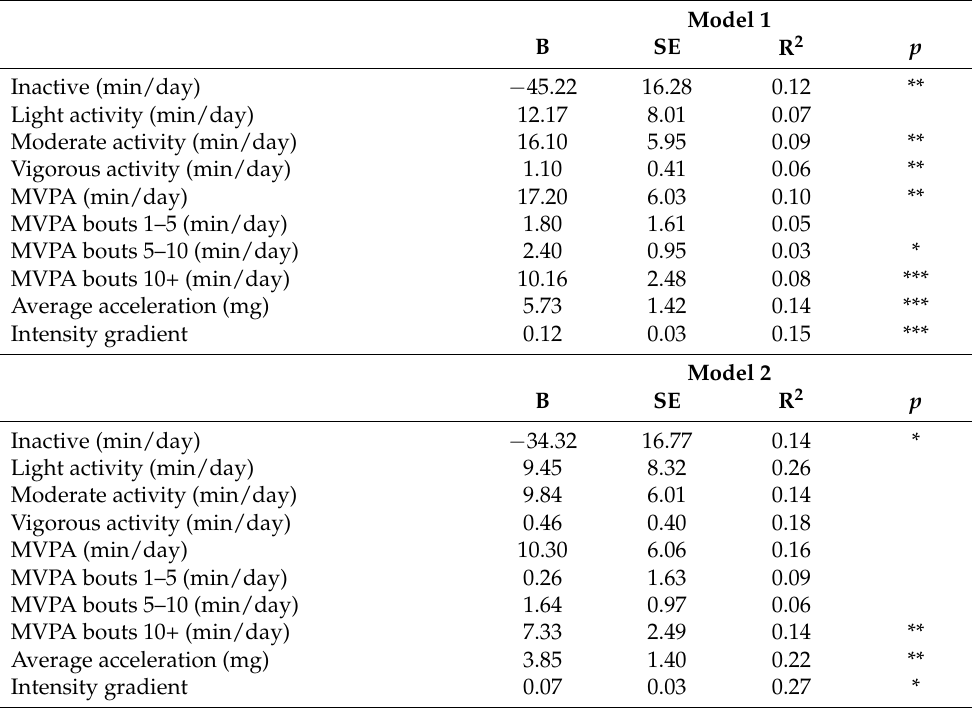
Table 3. Multiple linear regression models representing the differences between groups for physical activity